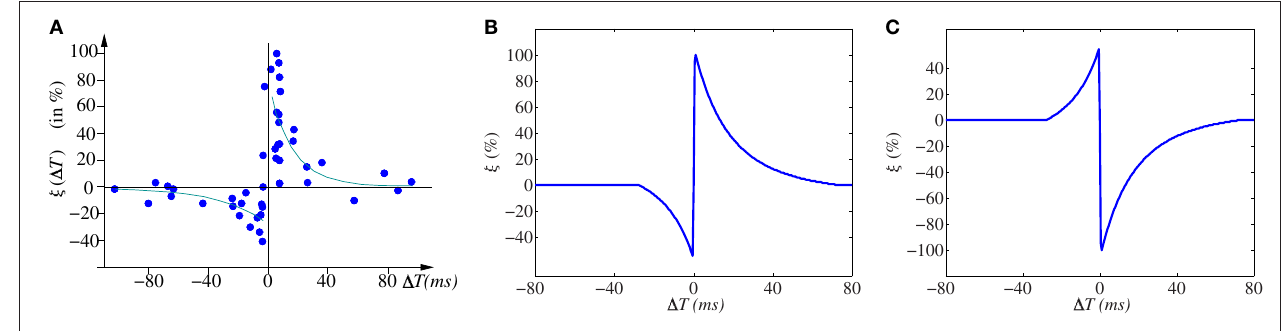
Figure 3 | (A) Experimentally measured STDP function ξ ( ∆ T ) on biological synapses (data from Bi and Poo, 1998, 2001). (B) Ideal STDP update function used in computational models of STDP synaptic learning. (C) Anti-STDP learning function for inhibitory STDP